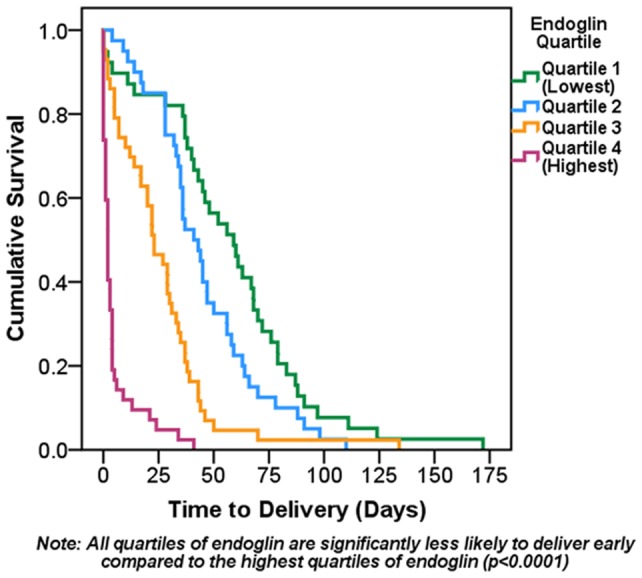
Kaplan-Meier estimates of time to delivery according to sEng quartiles.Kaplan-Meier survival function for time to delivery in all participants by quartile of sEng is depicted. Subjects remained in the analysis until delivery. Univariate Cox Proportional Hazard Models showed quartiles 3 and 4 of sEng had a significantly higher risk of early delivery (HR: 3.14, 95% CI: 1.99−4.98 and HR: 14.96, 95% CI: 8.73−25.62; both p<0.0001) compared to the lowest quartile. The second quartile showed no significant differences in time to delivery compared to quartile 1 (p = 0.07).